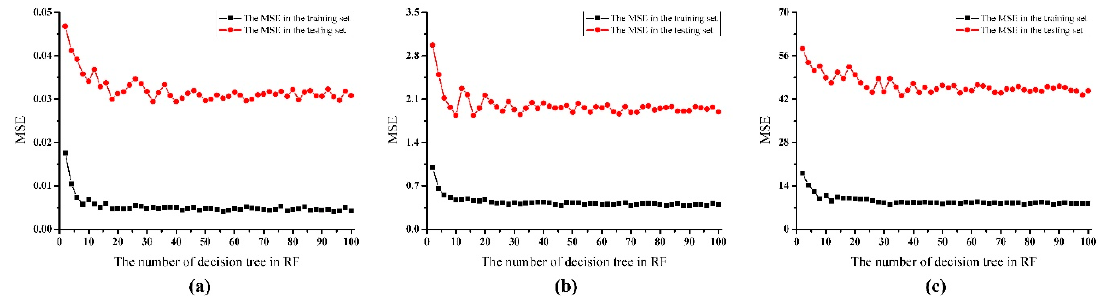
Figure 6. Searching of the decision trees for building the RF model: ( a ) overall ripeness; ( b ) SSC; ( c ) firmness.